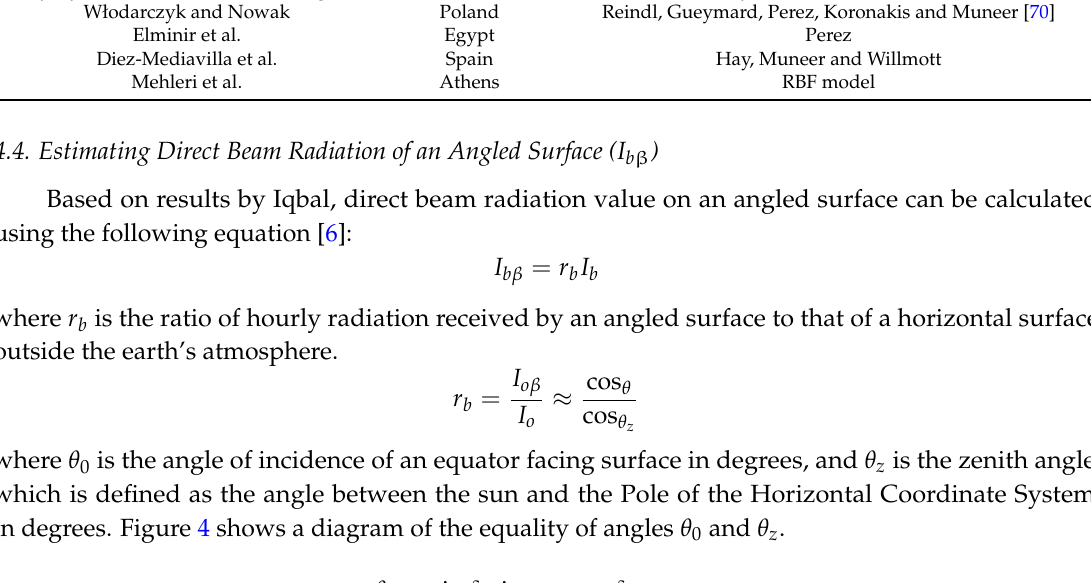
Table 7. Summary of studies on finding the most accurate diffuse models for inclined surfaces.